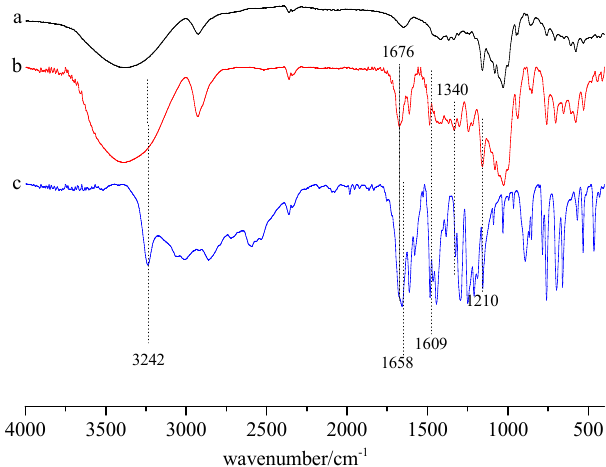
Figure 3. FTIR spectra of ( a ) β -CD, ( b ) SA/ β -CD, and ( c ) SA.